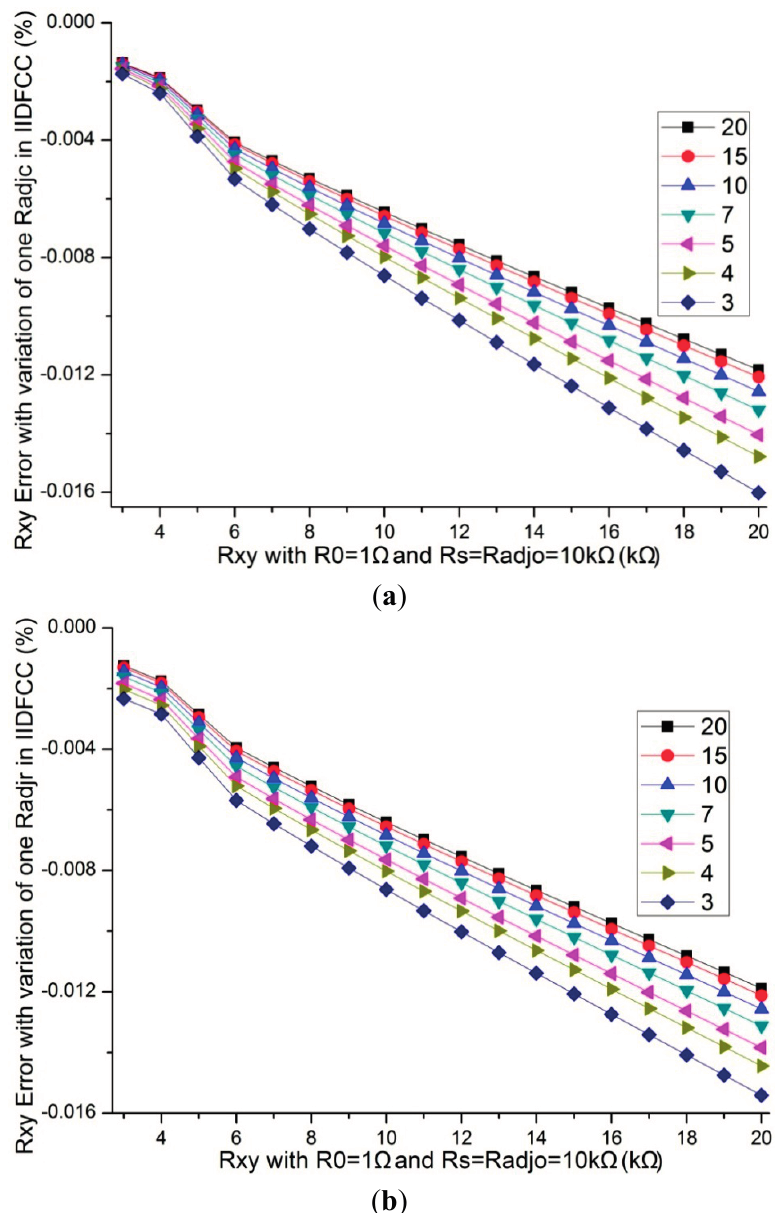
errors of the variation of one R xy = 10 k Ω ; ( b ) The R errors of the variation of one R adjo xy = 1 Ω and R = 10 k Ω 0 adjo